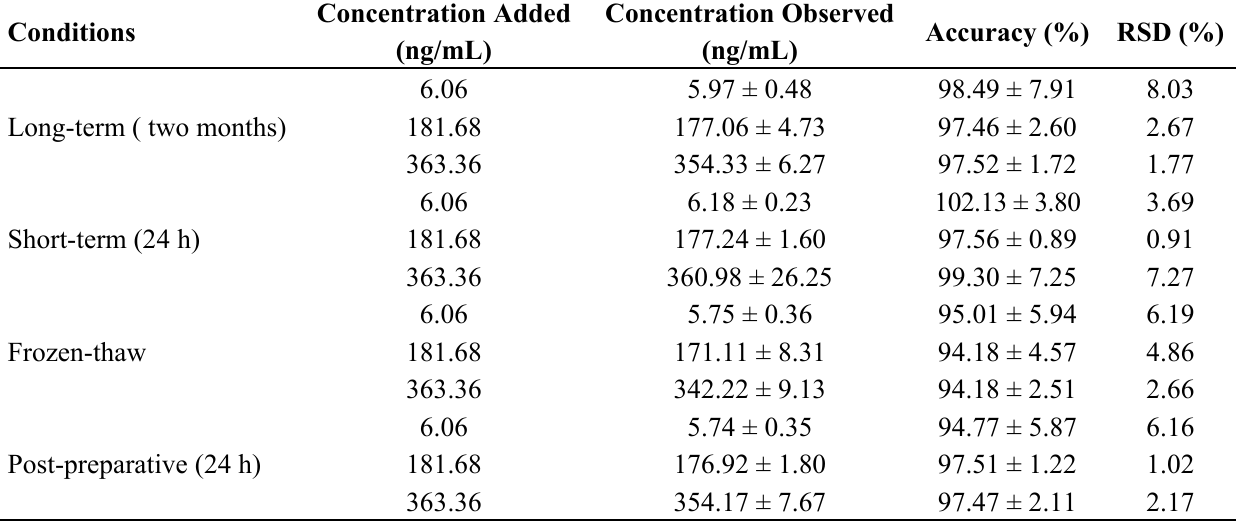
Table 3. The results of stability test (n = 3).